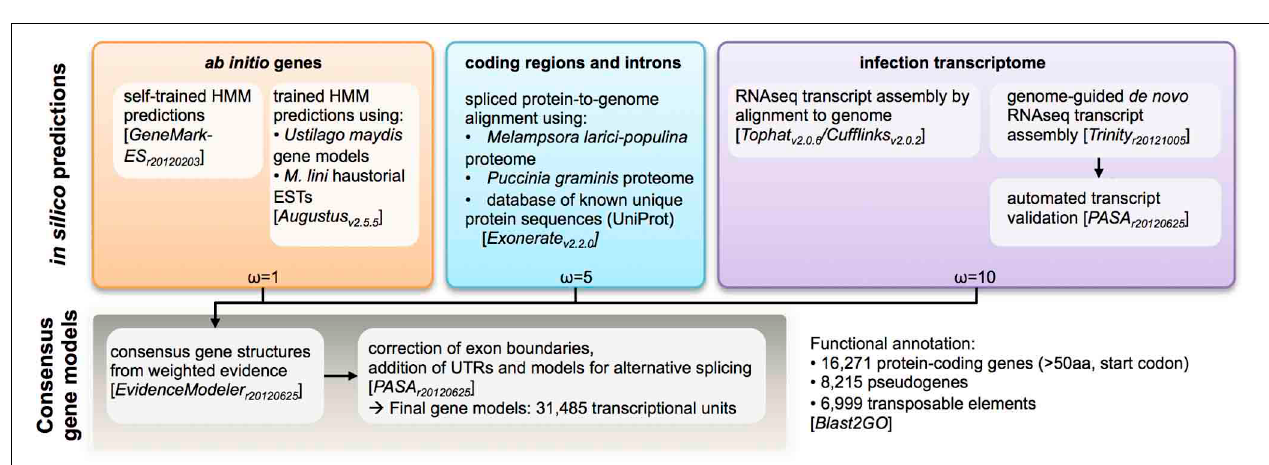
Scaffolds showing the best match are shown (light gray bars, in scale), with alignment scores including portion of query covered in match (cov.), sequence identity (id.), and alignment gaps (in bp).